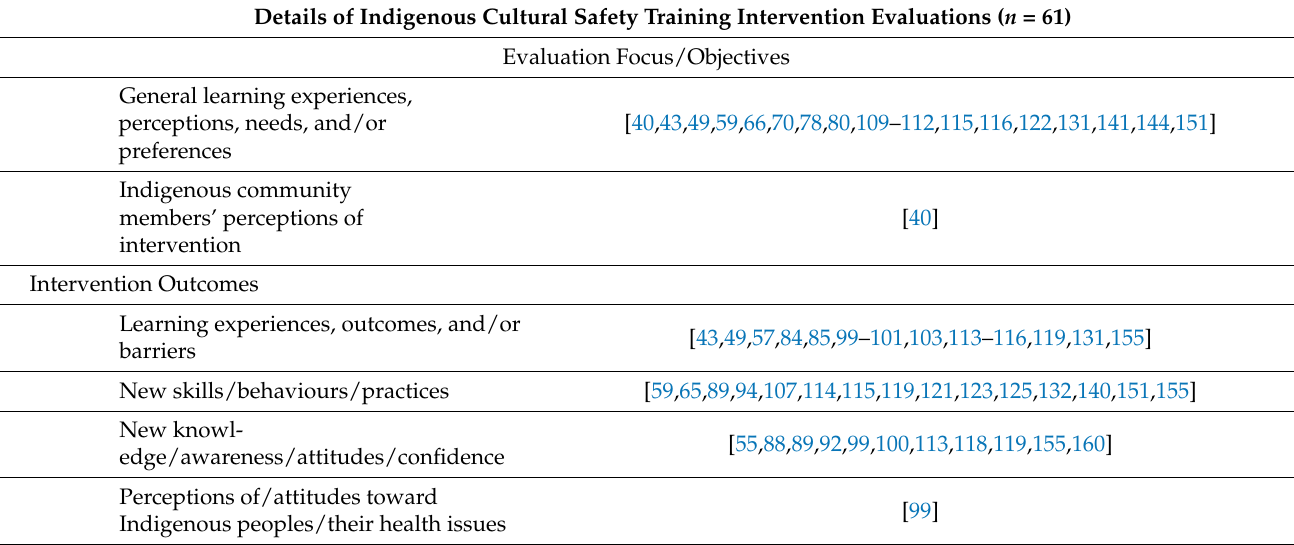
Table A5. Citations for Indigenous Cultural Safety Training Intervention